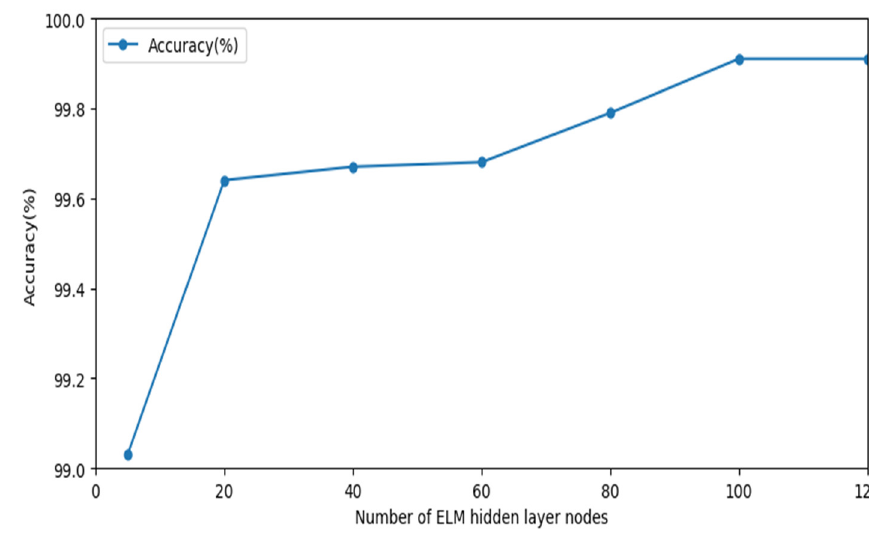
Figure 4. Anomaly detection accuracy for different number of nodes.